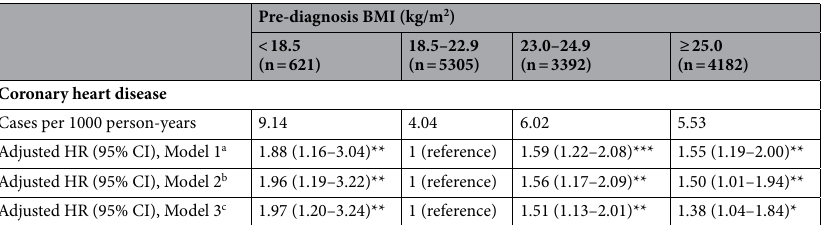
Table 2. Hazard ratio (HR) and 95% confidence (95% CI) intervals for coronary heart disease (CHD) in cancer survivors stratified by prediagnosis body mass index (BMI) categories. Data above are presented in numbers, HR, and HR (95% CI). HR hazard ratio, CI confidence interval, BMI body mass index, CHD coronary heart disease, NSAIDs non-steroidal anti-inflammatory-drugs, ICD international classification of diseases, NC not calculable. NOTE: Coronary heart disease includes ICD-10 codes I20-I25. a Calculated from Cox proportional hazards model adjusted for socioeconomic factors (age, sex, residential area, insurance premium). b Adjusted for lifestyle (smoking status, alcohol consumption, and physical activity), medical characteristics (fasting serum glucose, total cholesterol, systolic blood pressure, and Charlson comorbidity index), and family history (cardiovascular disease) in addition to the variables included in Model 1. c Adjusted for depression and medication use (aspirin, statin, anti-hypertensive drugs, anti-diabetic drugs, and NSAIDs). Depression was defined as outpatient visit or hospital admission with claims code for major depression disorder/major depression disorder, recurrent (ICD-10 codes: F32 and F33). * p < 0.05, ** p < 0.01, *** p <